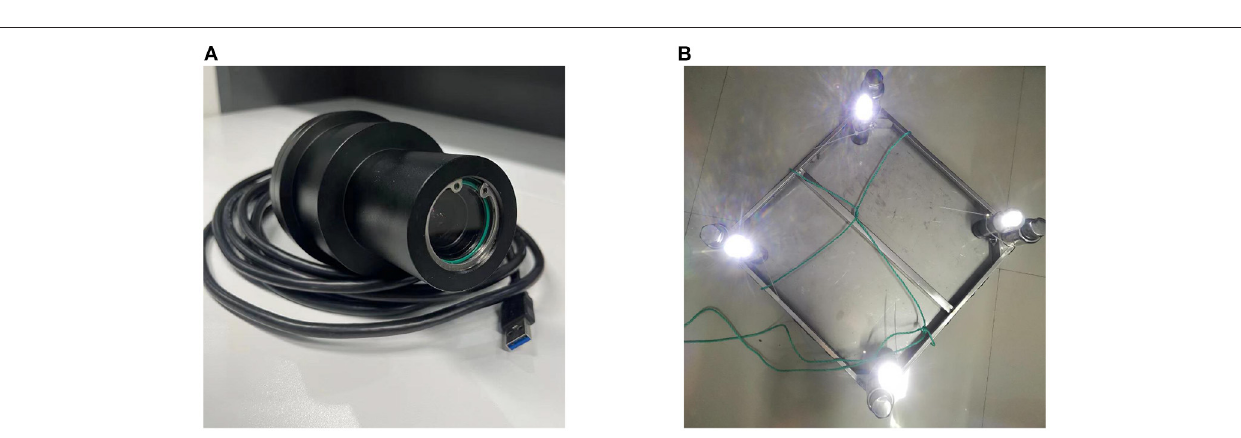
FIGURE 6 | The experimental equipments. (A) DVS with waterproof shell. (B) Targets with lights and steel plate.